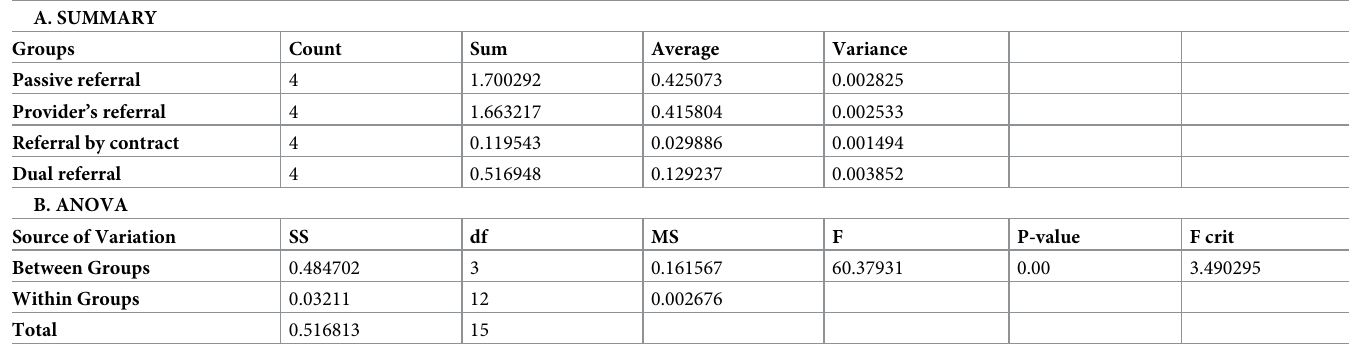
Table 1. One way ANOVA test for preferred referral strategies.